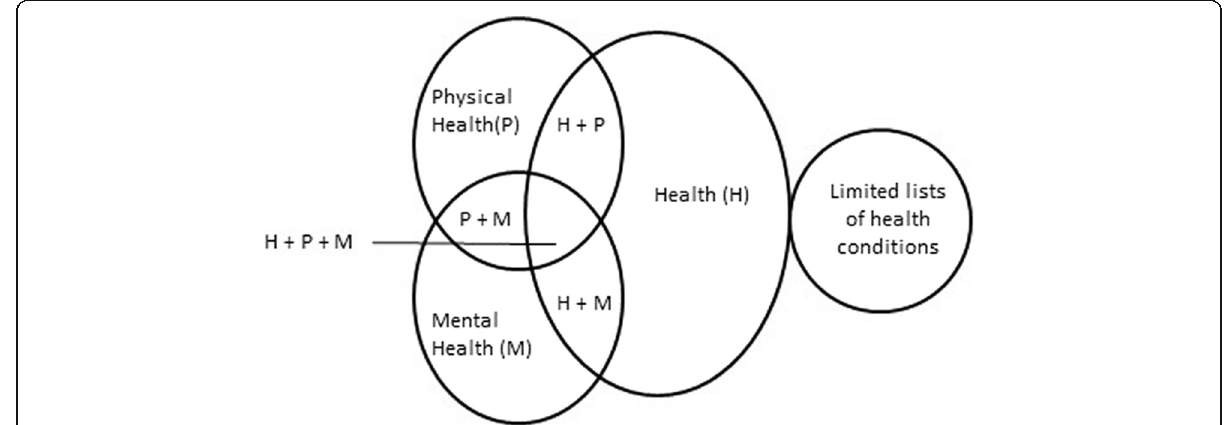
Fig. 1 Relationship between health, physical health and/or mental health ground and related